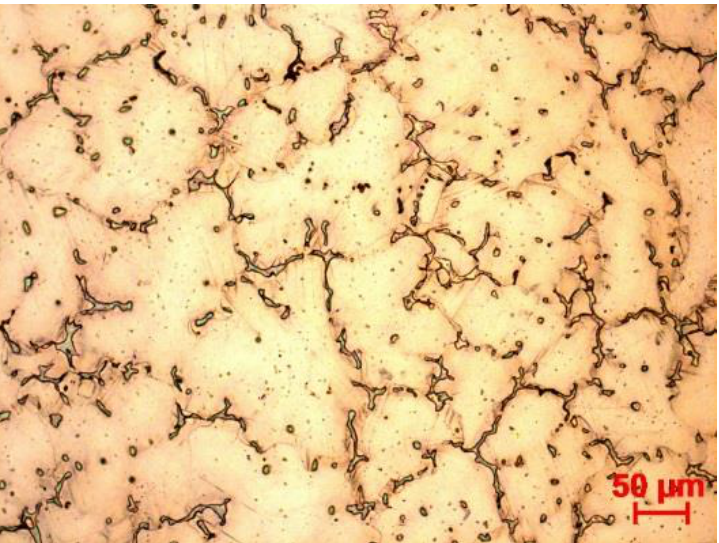
Figure 2. The microstructure of quenched Mg-1Mn-2Zn alloying systems at 200×.